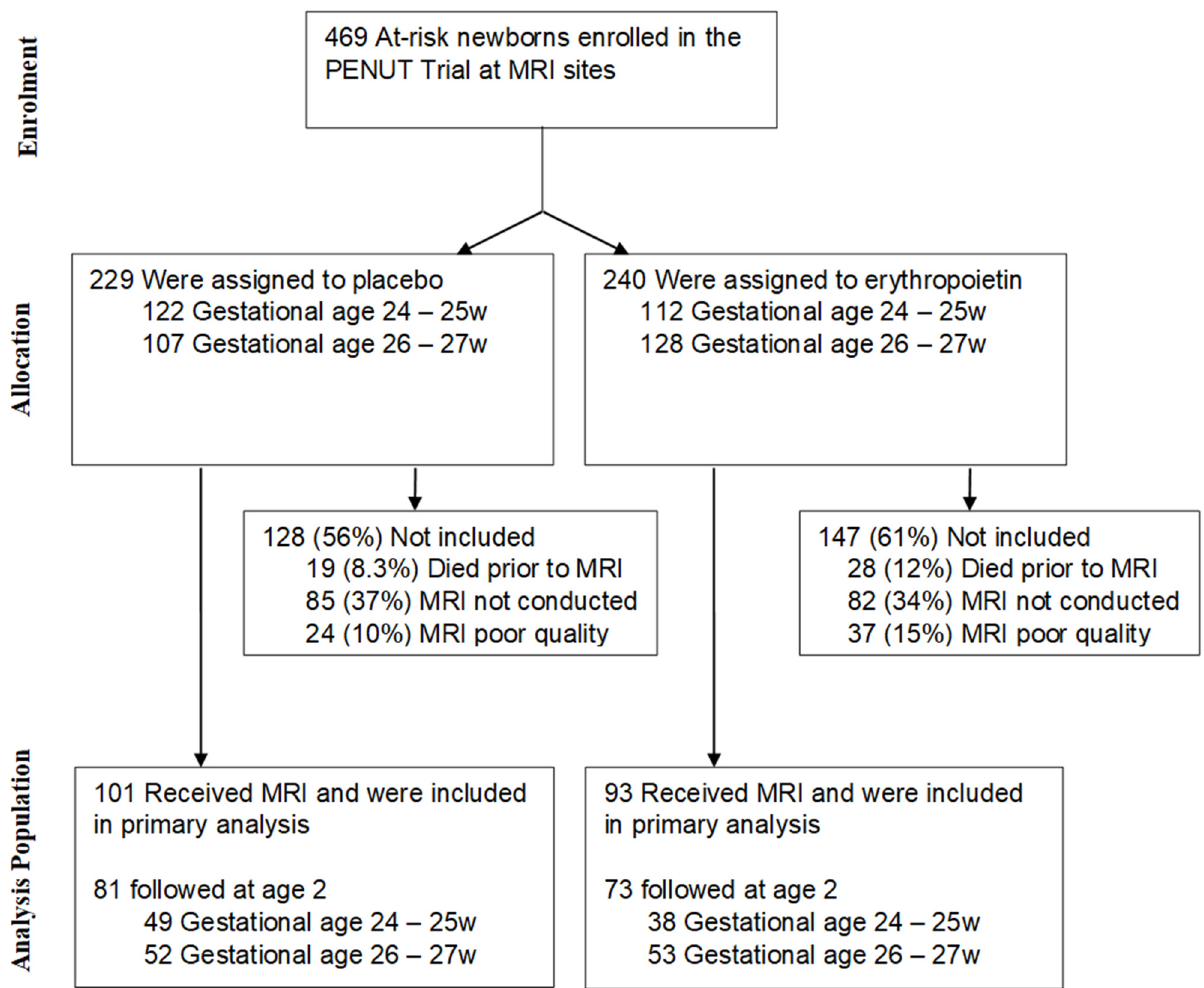
Figure 1. CONSORT diagram of PENUT MRI cohort.